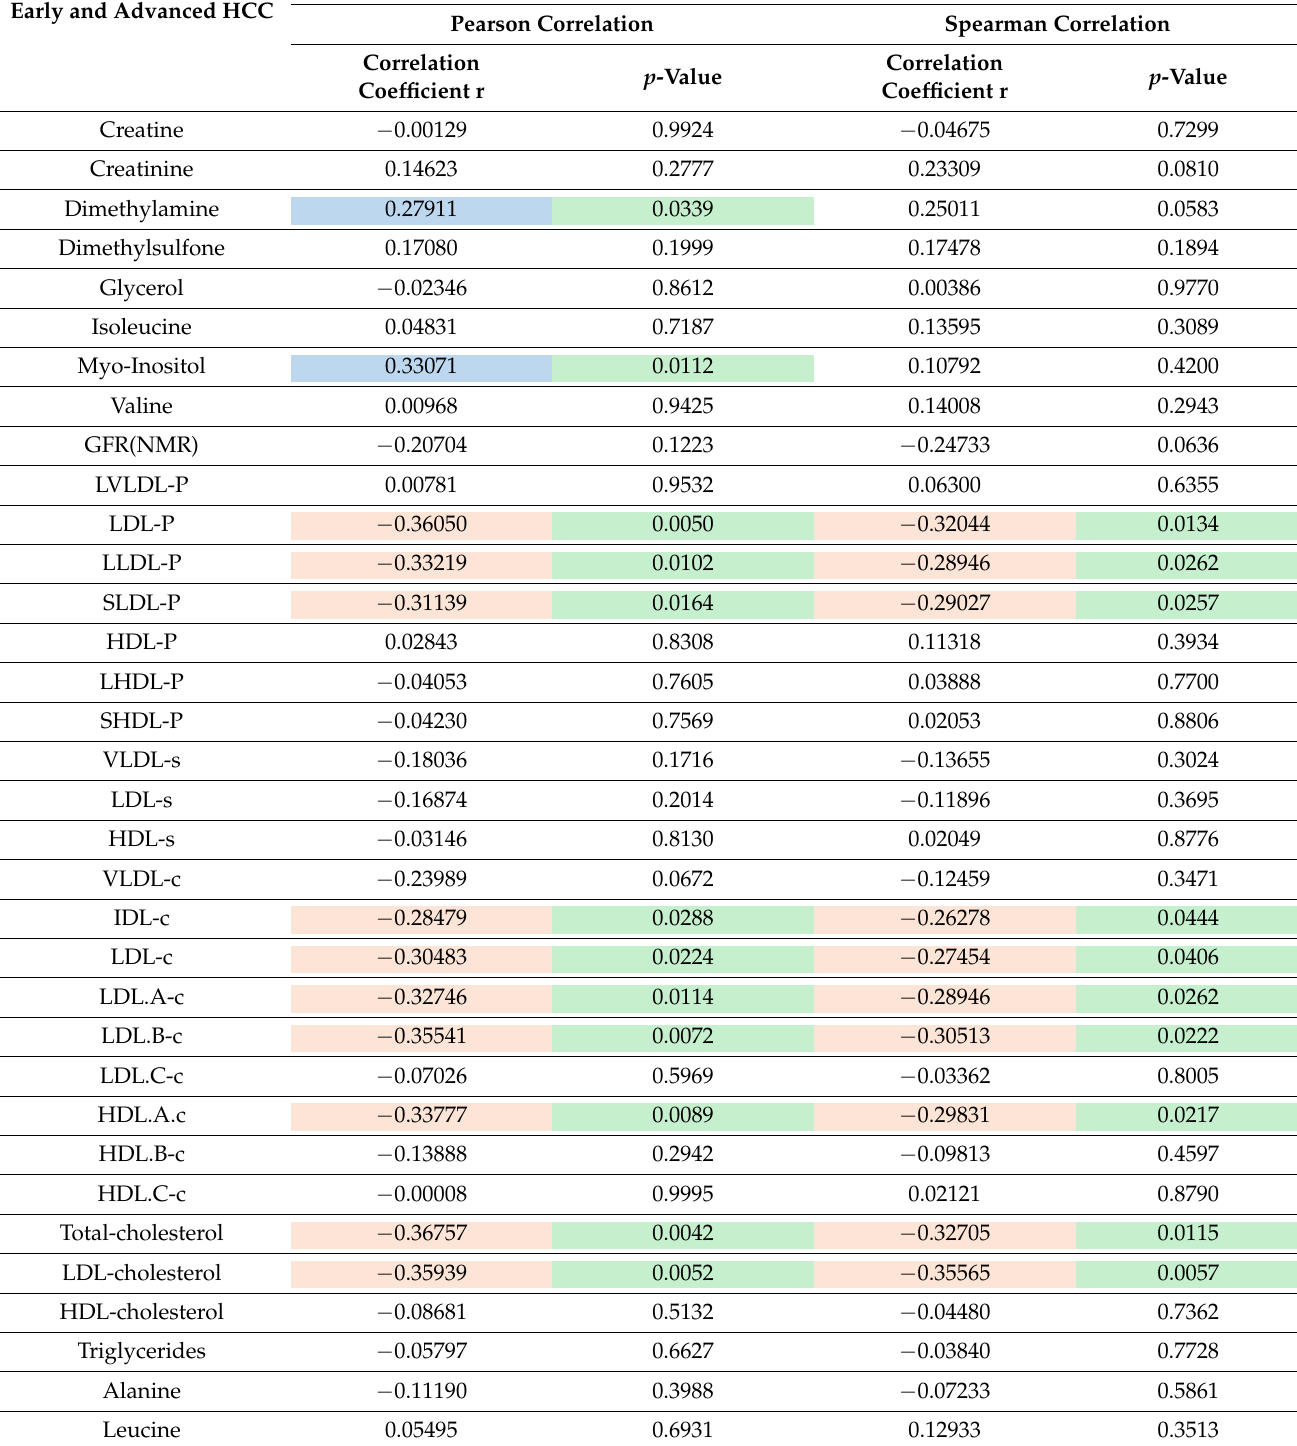
Table 5. Pearson and Spearman correlations of all tested parameters in HCC patients ( n = 60) to the overall survival. Significant p -values are highlighted in green. Positive correlations are highlighted in blue, negative correlations in